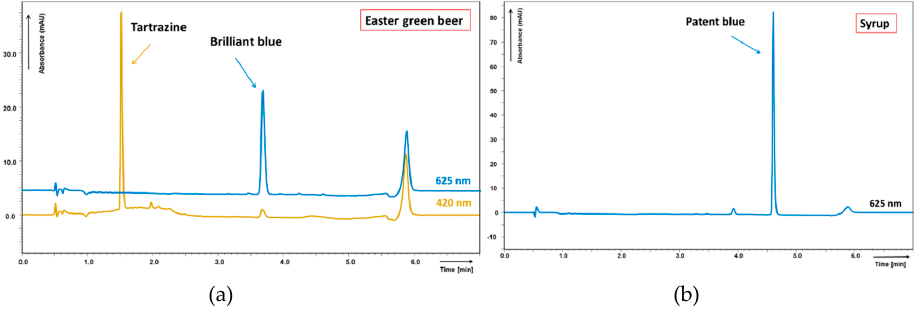
Figure 4. Chromatograms of sample matrices (analysed by method II): ( a ) seasonal coloured beer, ( b ) syrup. Found colorants in concentration: ( a ) tartrazine 3.49 mg L − 1 , brilliant blue 2.18 mg L − 1 ; ( b ) patent blue 44.51 mg L − 1 .